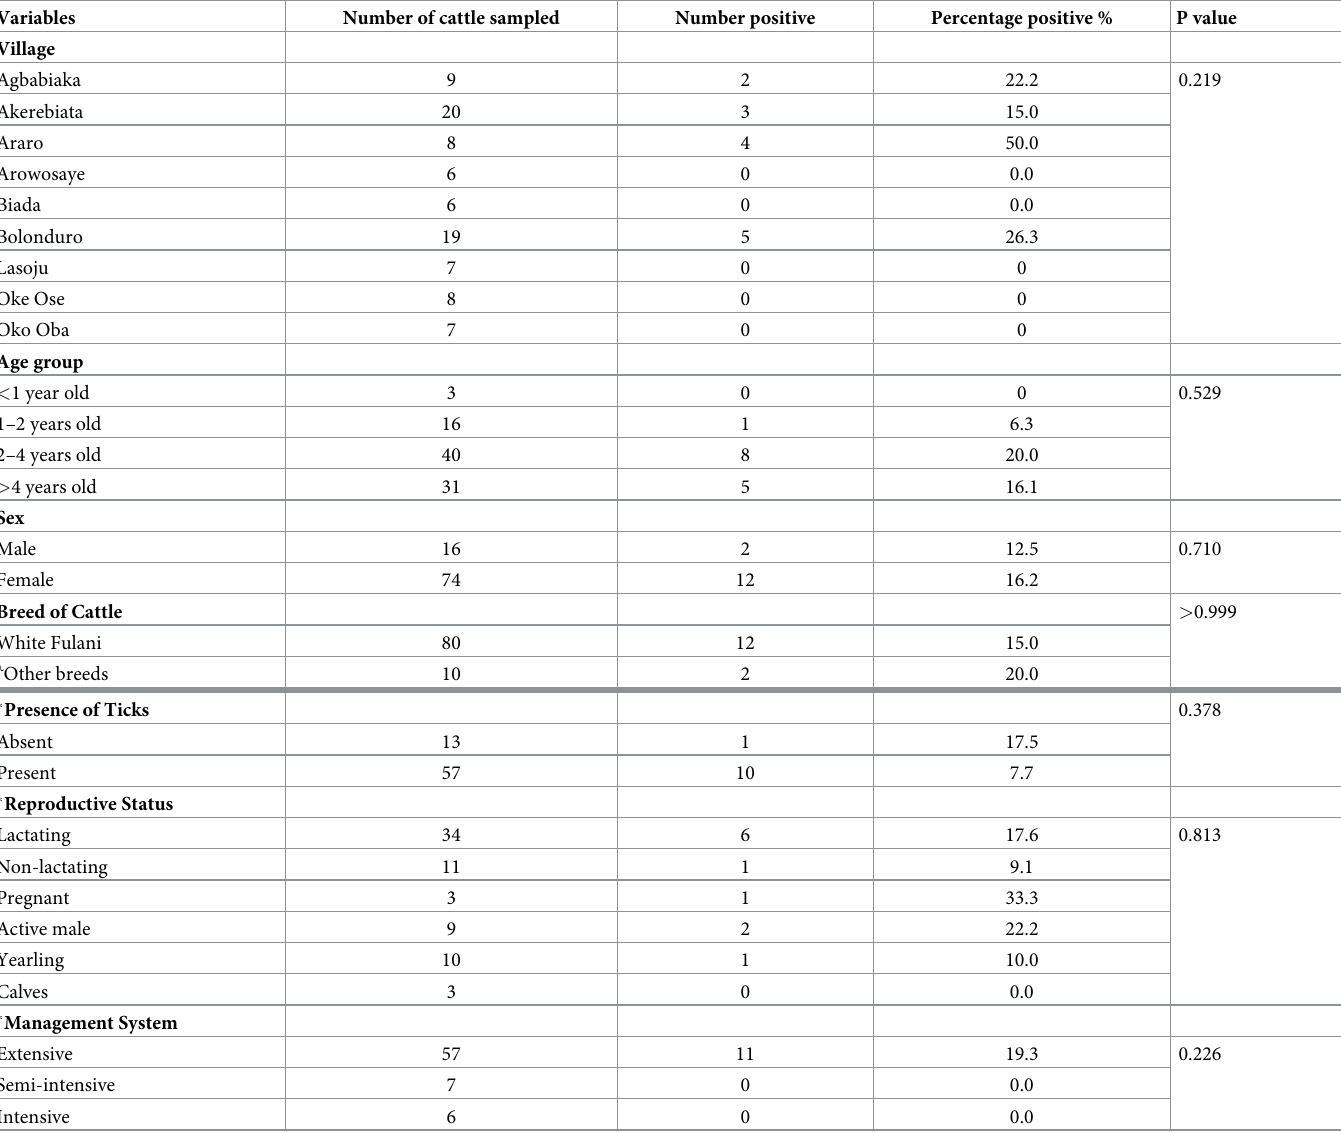
Table 2. Bivariate analysis of possible risk factors with seroprevalence of Coxiella burneti in cattle sampled from households in Kwara State, northern Nigeria.